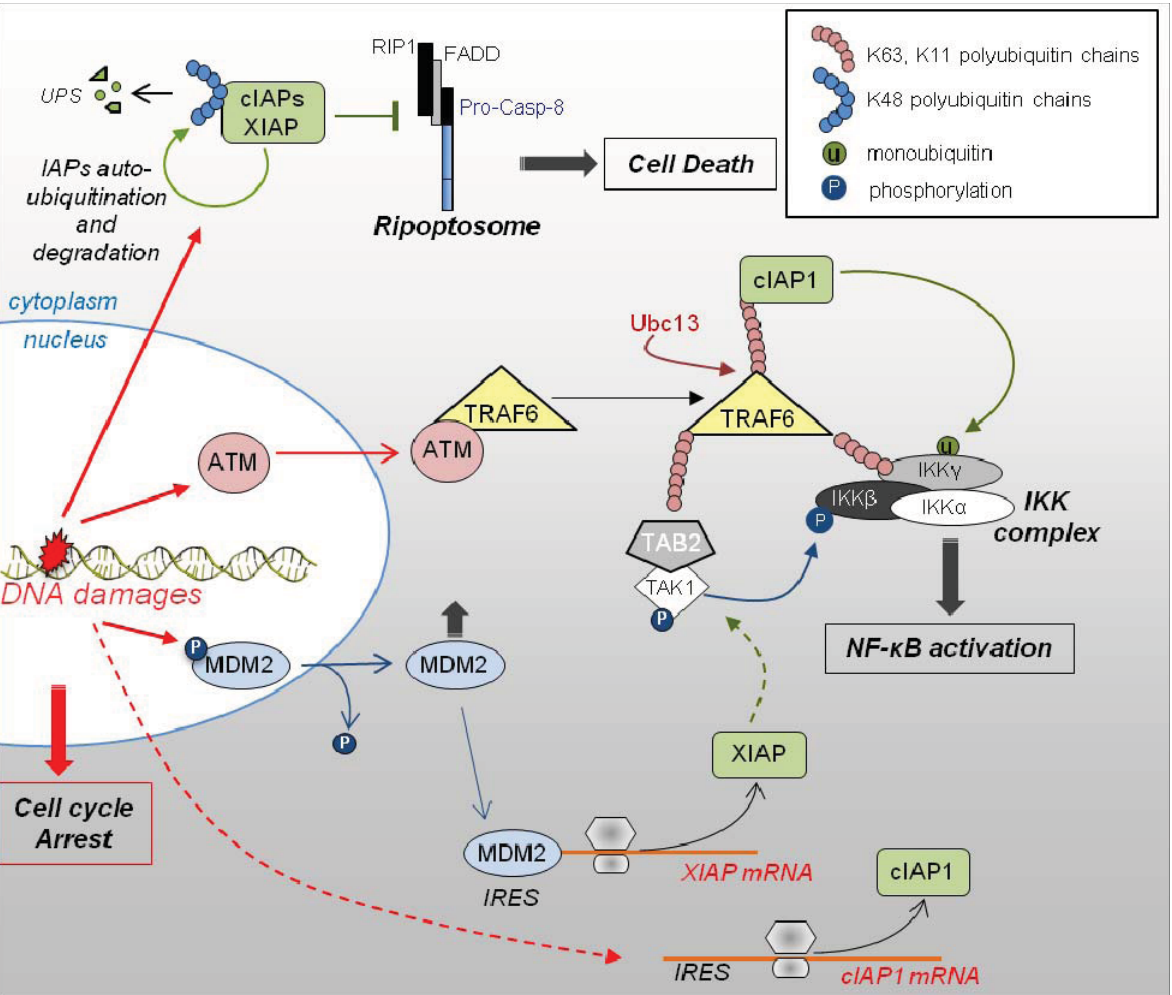
Figure 3. Role of IAPs in DNA damage response. Genotoxic stress-induced DNA strand breaks are very quickly detected by sensor molecules that activate cell cycle checkpoints and DNA repair mechanisms. They also induce IRES-dependent up-regulation of XIAP and cIAP1. MDM2 is dephosphorylated and exported from the nucleus to the cytoplasm where it physically interacts and stimulates XIAP IRES. cIAP1 and XIAP are regulators of DNA damage-mediated NF-(cid:2)B activating pathway. The sensor protein ATM is translocated from the nucleus to the cytoplasm where it interacts with TRAF6 and favors its Ubc13-mediated K63 ubiquitination. These Ub chains are a signal for the recruitment of cIAP1, TAB2/TAK1 complex and IKK complex. TAK1 induces the phosphylation of